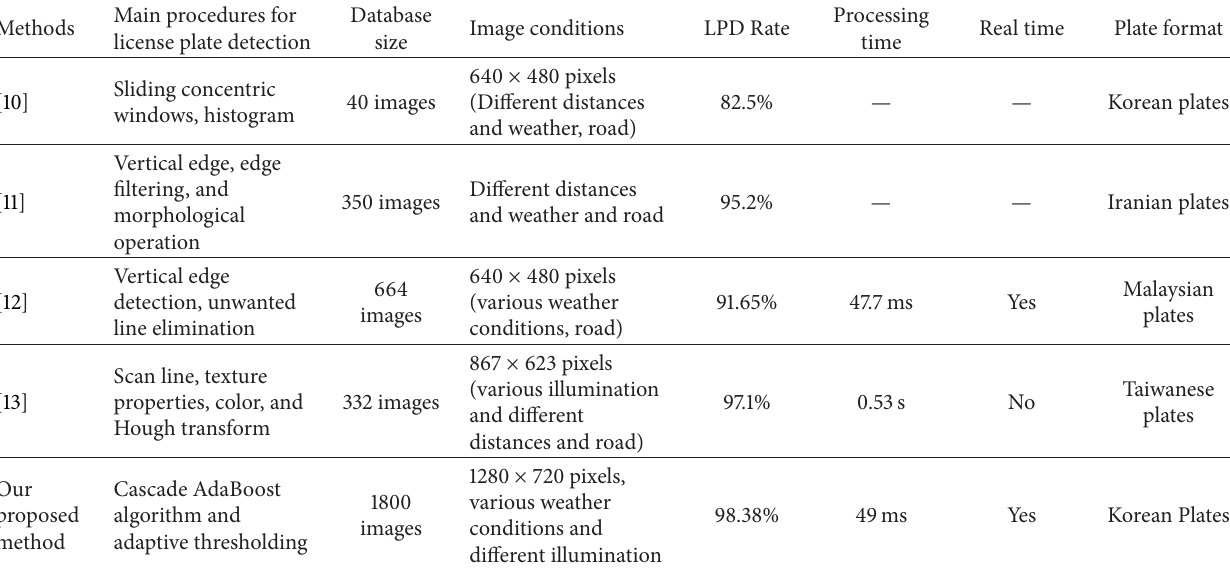
Table 3: Performance comparison of some typical ALPR systems for